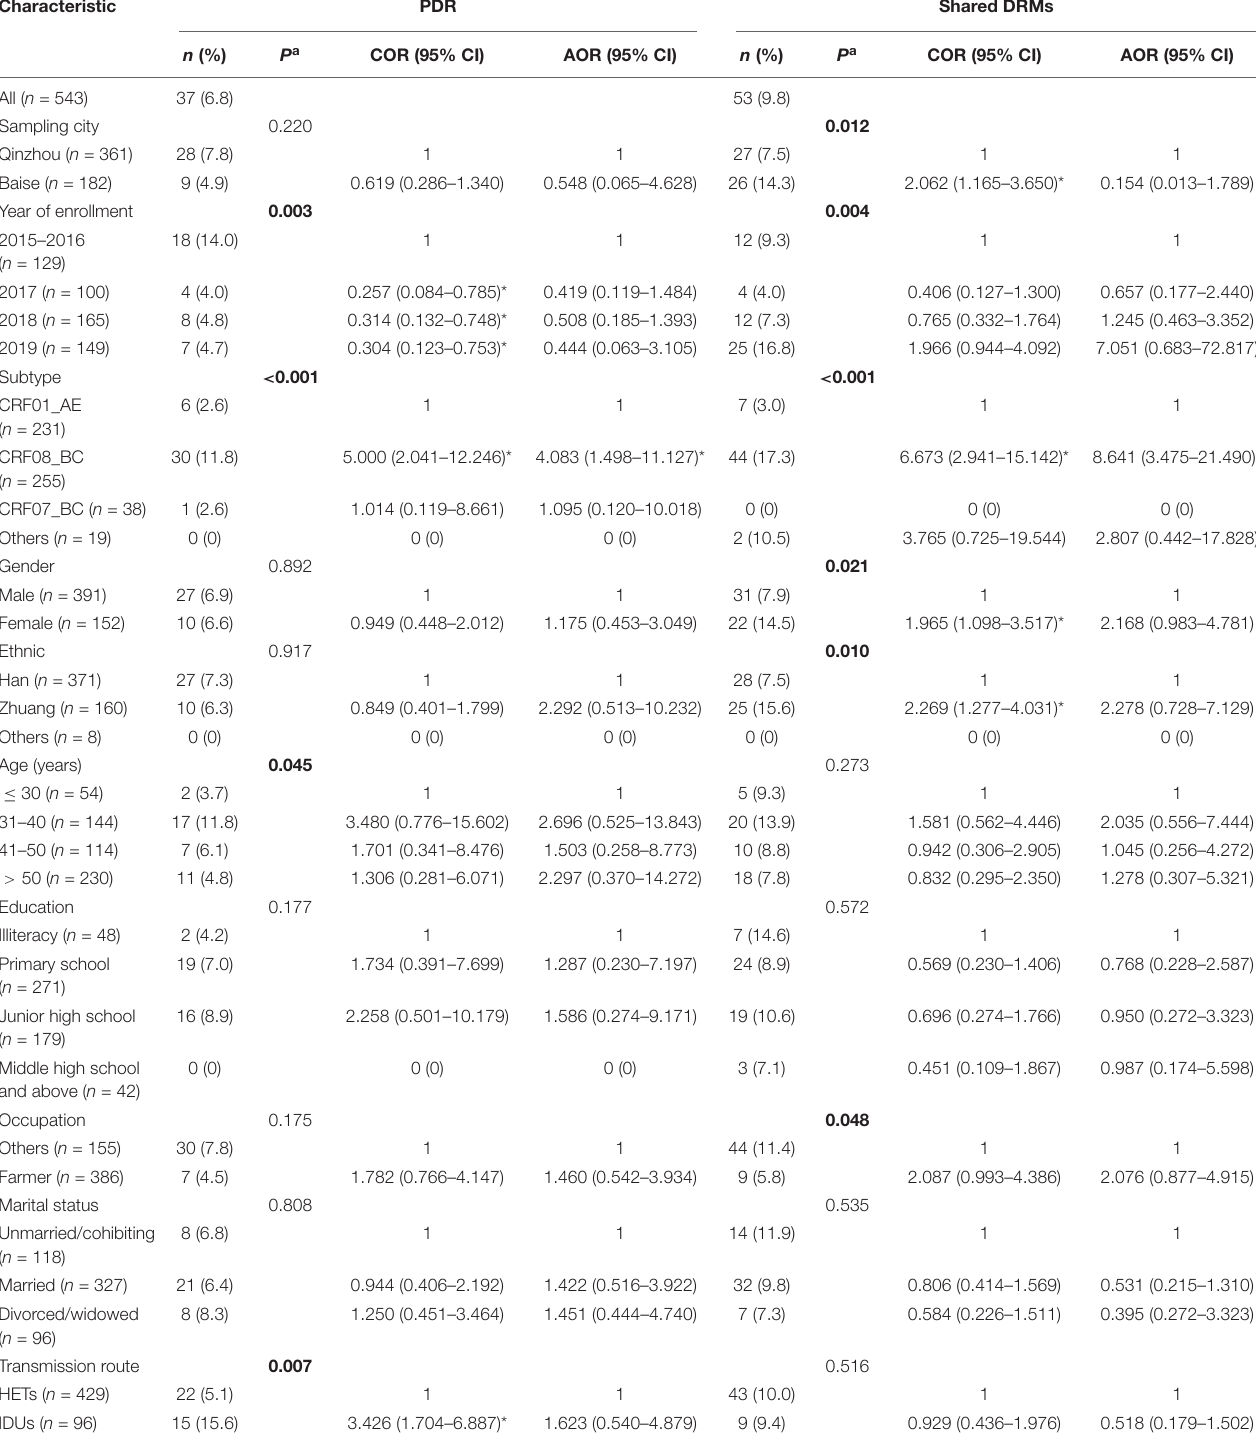
TABLE 3 | Factors associated with PDR and shared DRM among individuals within clusters in HIV-1 genetic network. Characteristic